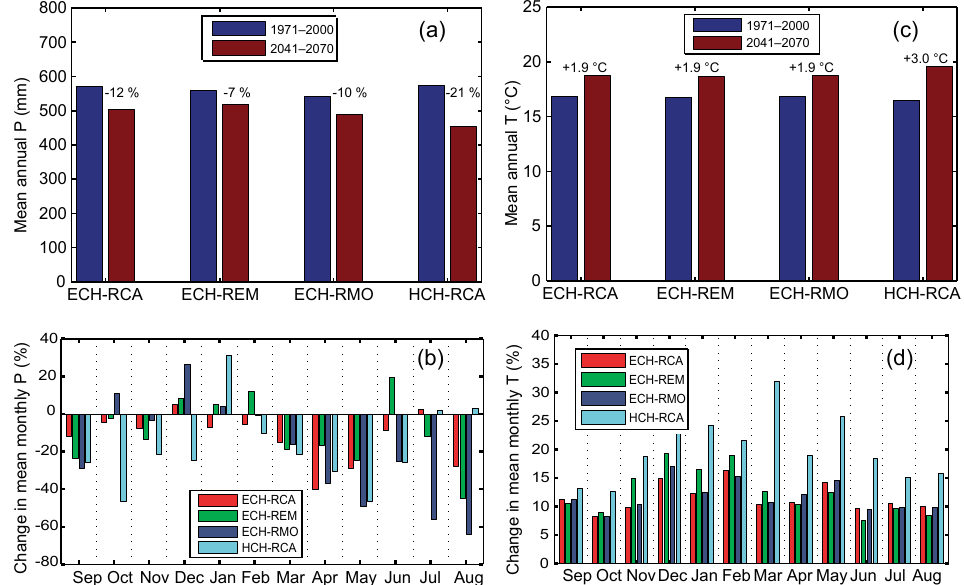
Figure 4. Mean annual precipitation P (a) and temperature T (c) predicted by the four climate models for the reference (1971–2000), blue bars, and future (2041–2070), red bars, periods. Relative change in mean monthly precipitation P (b) and temperature T (d) between the reference and future periods for the four climate